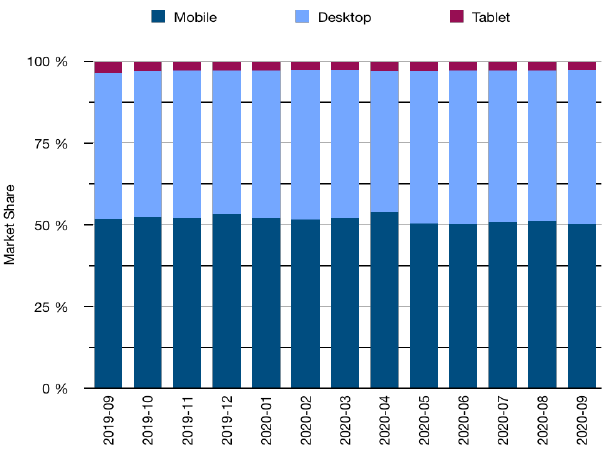
Figure 4. Desktop vs Mobile vs Tablet Market